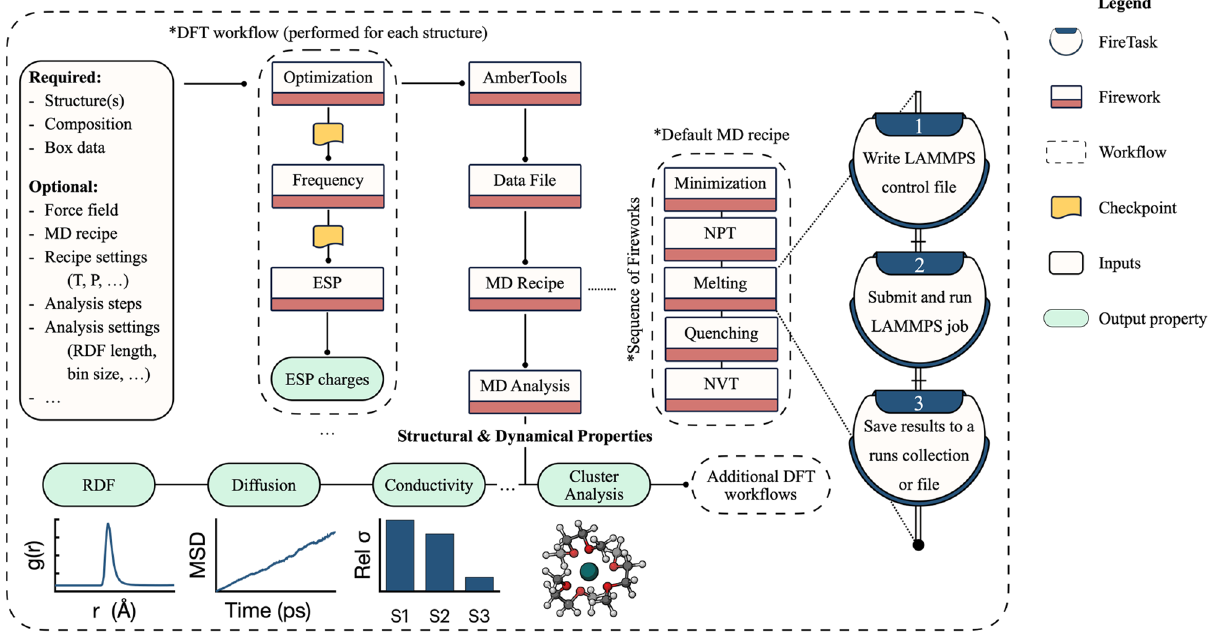
Figure 9. Diagram for the workflow that seamlessly integrates DFT calculations with MD simulations to derive various structural and dynamical properties of liquid